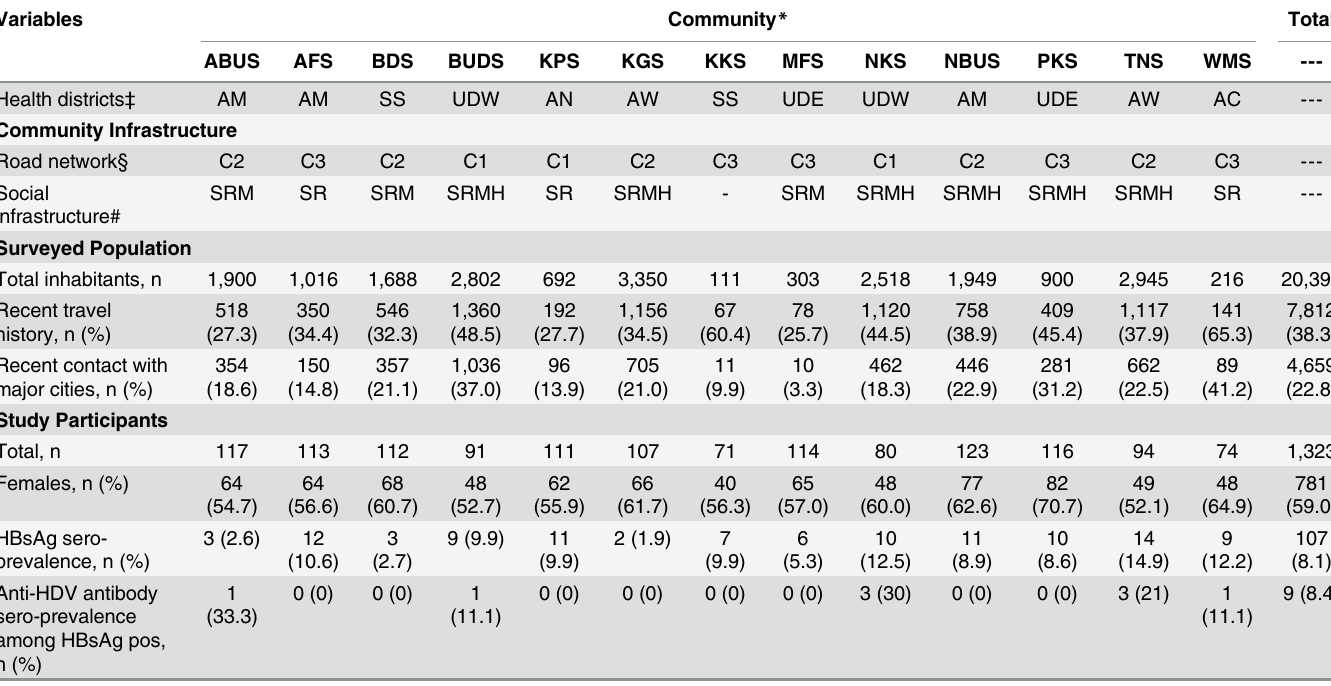
Table 1. Characteristics of the study population and HBsAg and anti-HDV antibody seroprevalences.